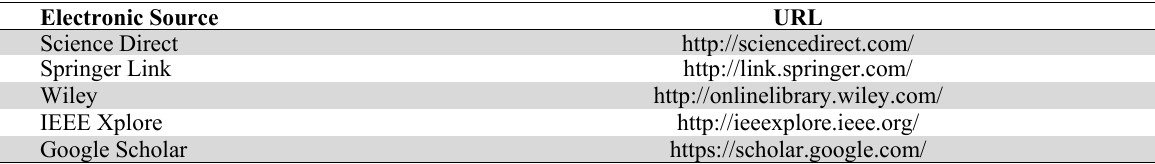
Table 1 Electronic source (database) Electronic Source